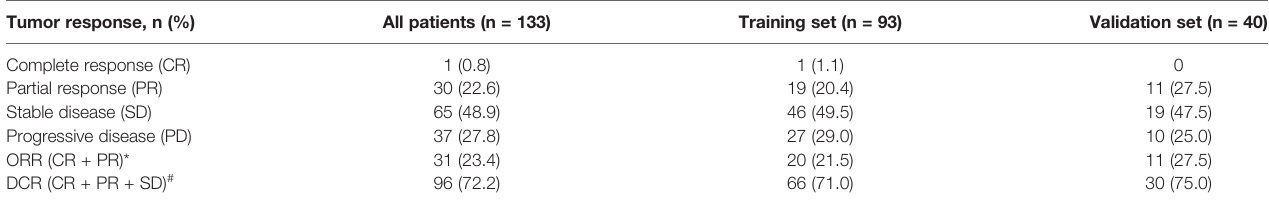
TABLE 2 | Tumor responses.